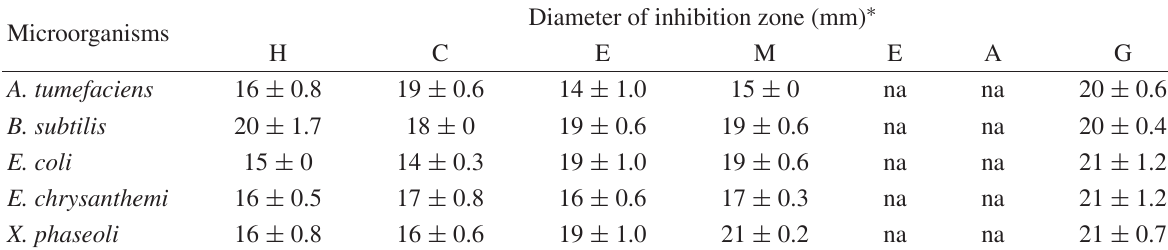
TABLE 1: Zone of inhibition of different extracts of Ginkgo biloba